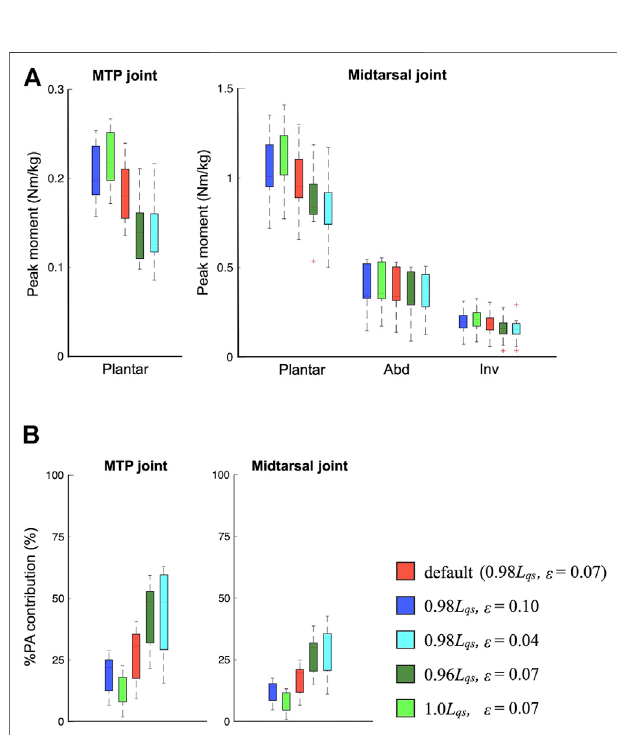
FIGURE 8 | Comparisons of the mean peak moments (A) and %plantar aponeurosis (PA) contribution (B) at toe-off when the PA stiffness parameters were